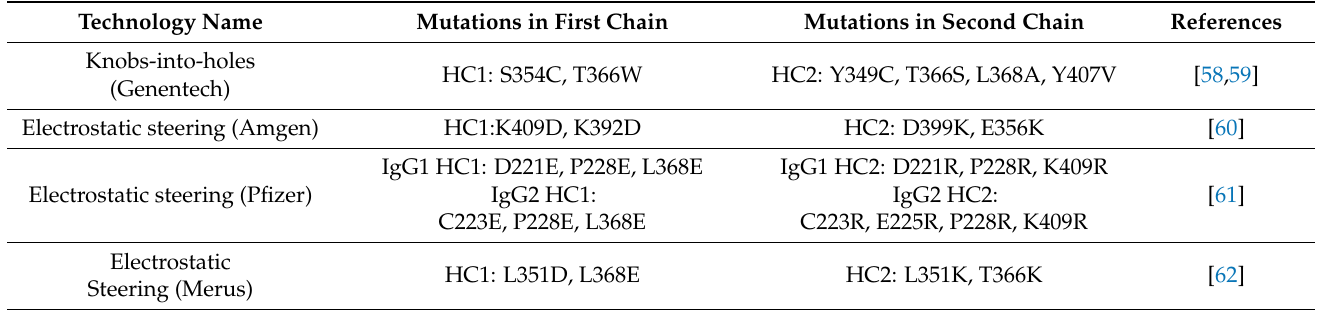
Table 2. Strategies and mutations to ensure cognate light and heavy chain assembly in bispecific antibodies with the numbering of the European Union amino acid sequence (All are in human IgG1 unless mentioned otherwise).